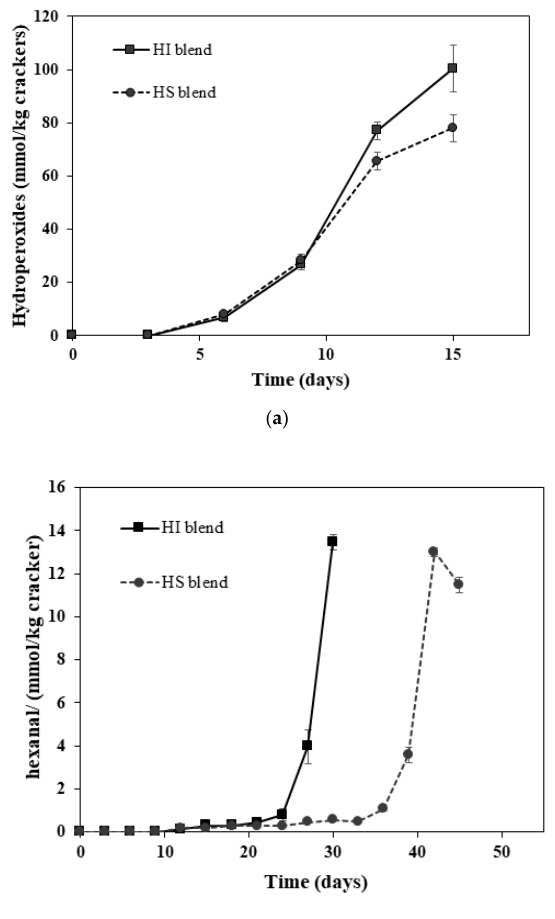
Figure 2. Formation of ( a ) lipid hydroperoxides and ( b ) headspace hexanal in crackers made with hydrogenated soybean fat + interesterified soybean fat (HI, SFC = 32.0%) or hydrogenated soybean fat + sunflower oil (HS, SFC = 24.9%). Data points represent means ( n = 3) ± standard deviations. Some standard deviations lie within the data points.